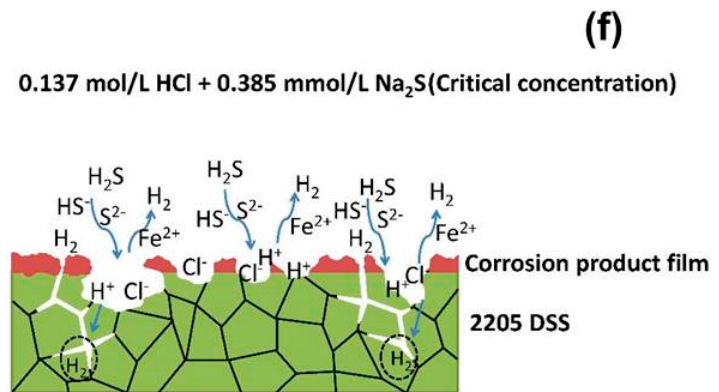
Figure 12. Corrosion mechanism models of 2205 DSS: ( a ) 0.1 mol/L HCl, ( b ) 0.137 mol/L HCl, ( c ) 0.1 mol/L HCl + Na 2 S, ( d ) corrosion initiation in 0.137 mol/L HCl + Na 2 S, ( e ) initiation and propagation of localized defect in 0.137 mol/L HCl + 0.385 mmol/L Na 2 S, ( f ) corrosion propagation in the entire surface of 2205 DSS in 0.137 mol/L HCl + 0.385 mmol/L Na 2 S